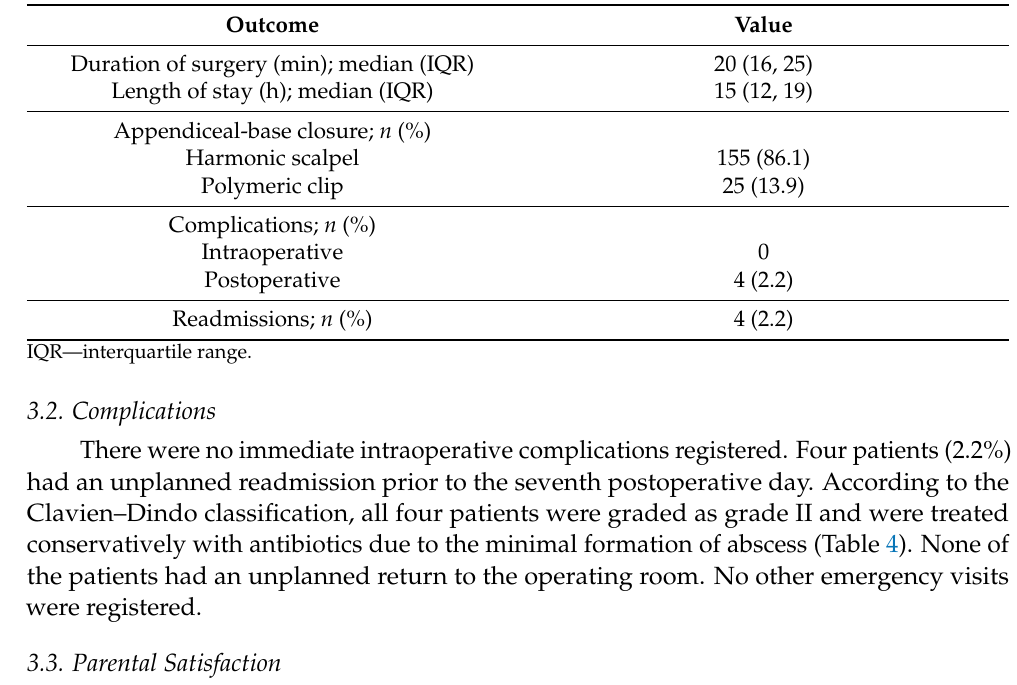
Table 3. Outcomes of